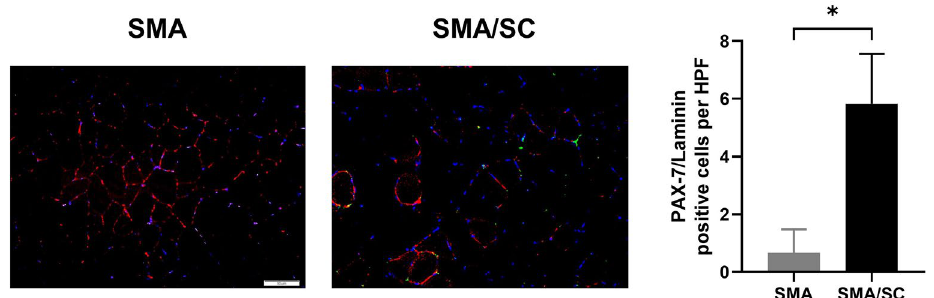
Figure 8. Immunofluorescent staining of muscle in SMA mice with or without hAFSC transplantation. Muscle of SMA mice with transplantation expressed Laminin (red color), PAX7 (green color) and DAPI (blue color).